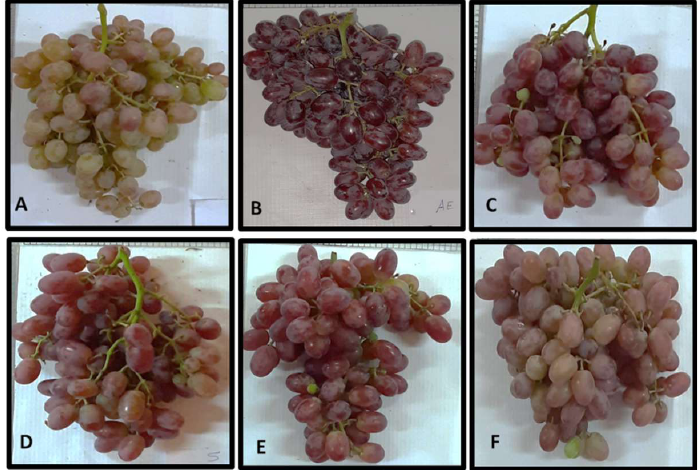
Figure 4. Effect of foliar spraying with ZnO NPs on coloring of Crimson seedless grape clusters. ( A ): water-treated clusters as a control, ( B – E ): 25, 50, 100 and 250 ppm ZnO NPs, ( F ): 250 ppm ZnO.